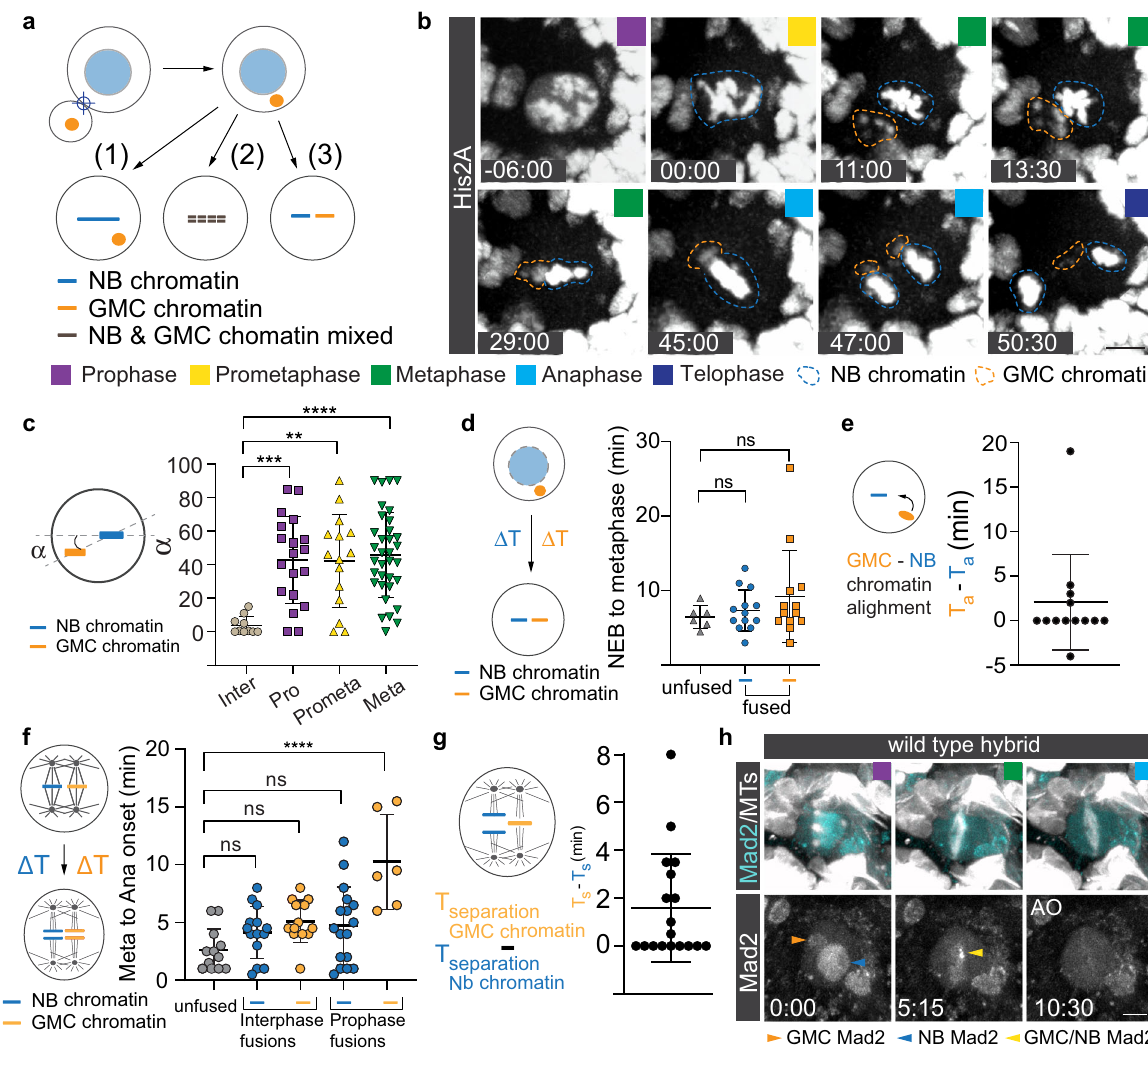
Fig. 1 NB-GMC hybrid cells can independently align NB and GMC chromatin at the metaphase plate. a Potential outcomes of NB-GMC fusions: NB – GMC derived hybrid cells could (1) only align neuroblast chromosomes, (2) congress a mix of endogenous and ectopic chromosomes or (3) separately align NB and GMC chromosomes at the metaphase plate. b Representative image sequence of a dividing third instar larval NB-GMC hybrid cell obtained from an interphase fusion, expressing the histone marker His2A::GFP (dashed blue circle; endogenous chromatin, dashed orange circle; ectopic chromatin). c Alignment of endogenous and ectopic chromatin in hybrid cells derived from interphase (inter), prophase (pro), prometaphase (prometa) or metaphase (meta) fusions were quanti fi ed with angle measurements in metaphase. d Chromosome alignment time for NB (endogenous; blue circles) and GMC- derived (ectopic) chromosomes (orange squares) compared to unfused control neuroblasts (grey triangles). e The time difference (T a ; time of alignment) between NB/endogenous (blue line) and GMC/ectopic (yellow ball) chromatin was measured and plotted. f Metaphase to anaphase onset was measured for NB/endogenous (blue lines) and GMC/ectopic (orange lines) chromatin, using chromatid separation as a reference. g Time difference between NB and GMC chromatin anaphase onset in NB-GMC hybrid cells. h Representative images of wild type hybrid cells expressing Mad2::GFP (cyan, top row; white, bottom row) and the spindle marker cherry::Jupiter (white top row). Orange, blue and yellow arrowheads refer to GMC-derived, NB-derived and merged Mad2, respectively. AO; Anaphase onset. Colored boxes represent corresponding cell cycle stages. One-way ANOVA was used for c , d , f . Error bars correspond to standard deviation (SD). * p < 0.05, ** p < 0.01, *** p < 0.001, **** p < 0.0001. For this and subsequent fi gures, exact p values and complete statistical information can be found in Supplementary Data 1. Time in min:sec. Scale bar is 5 μ m.